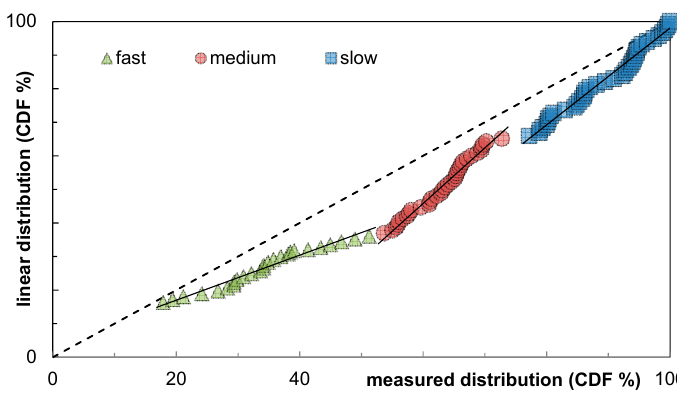
Figure 4. Q–Q plot of cumulative distribution functions (CDF) of boarding rate percentiles with measured boarding rates against a linear boarding progress with r nB = 5.5 s/pax.